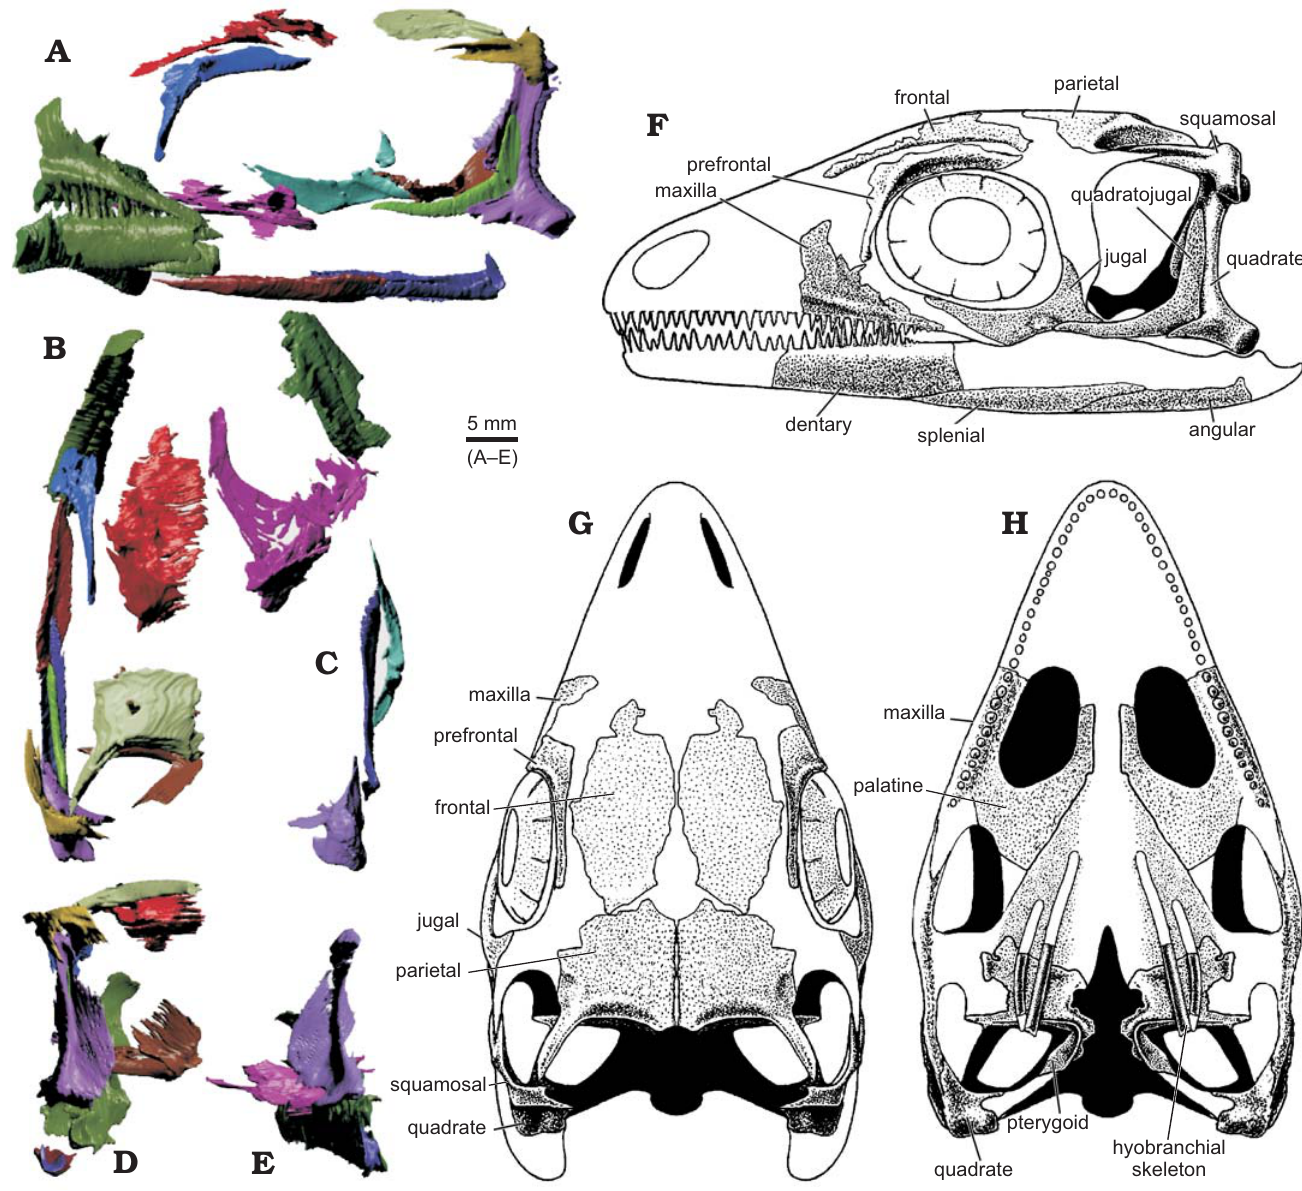
Fig. 8. Tomographic three-dimensional representations of the skull bones of ZPAL AbIII/3191 long-necked reptile Ozimek volans gen. et sp. nov. in their proposed original arrangement (A–E) and restorations of the skull (F–H); in lateral ( A , F ), dorsal ( B , G ), palatal ( C , H ), posterior ( D ), and anterior ( E ) views. F–H not to